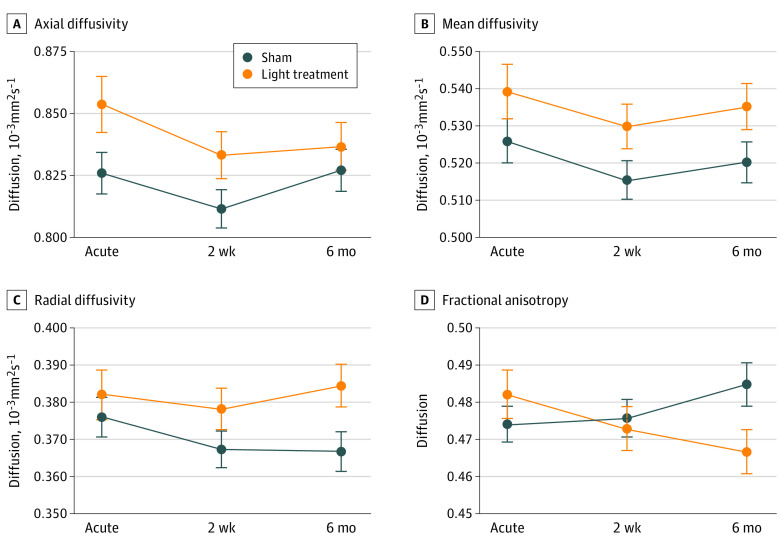
Effect of Light Treatment on Diffusion ParametersThe effect of light treatment on diffusion parameters as predicted by linear mixed effect model. Error bars represent standard error of the mean. A, Axial diffusivity. Time, P = .02; treatment, P = .89; time x treatment, P = .47. B. Mean diffusivity. Time, P = .04; treatment, P = .08; time x treatment, P < .001. C, Radial diffusivity. Time, P = .11; treatment, P = .77, time x treatment, P < .001. D, Fractional anisotropy. Time, P = .02; treatment, P = .58; time x treatment, P < .001.